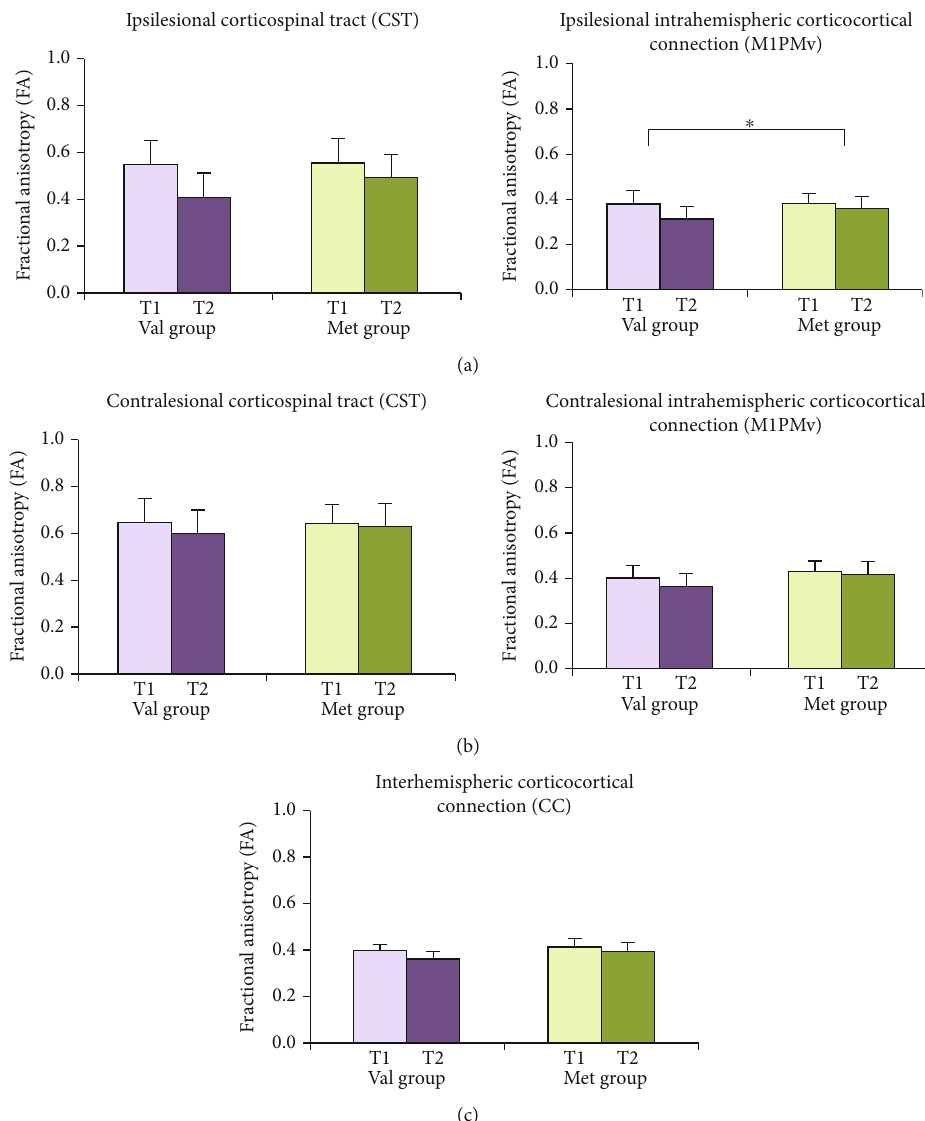
Figure 3: The absolute values of fractional anisotropy (FA) in the (a) ipsilesional, the (b) contralesional, and the (c) interhemispheric motor- related tracts between two weeks and three months after stroke in each BDNF genotype. CC: corpus callosum; CST: corticospinal tract; M1PMv: intrahemispheric corticocortical connection from the primary motor cortex to the ventral premotor cortex; Met group: BDNF methionine (Met) allele carriers; T1: two weeks after stroke onset; T2: three months after stroke onset; Val group: BDNF valine (Val) homozygotes. ∗ P < 0 : 05